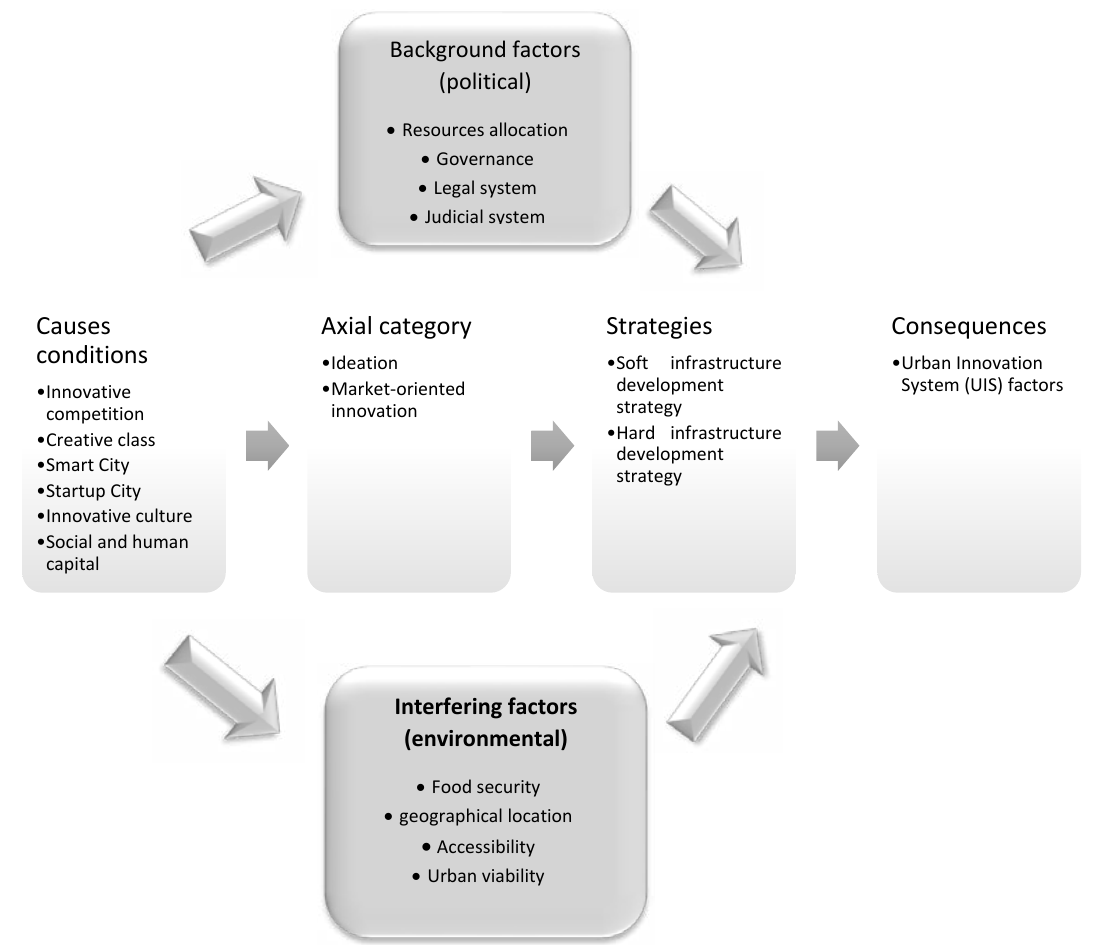
Fig. 4: The paradigm model of UIS